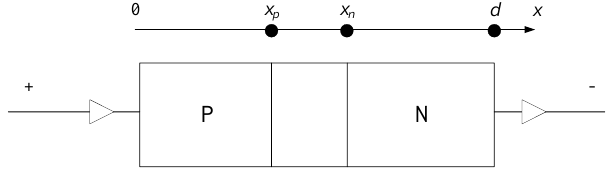
Figure 2. Ideal PN junction under forward bias.